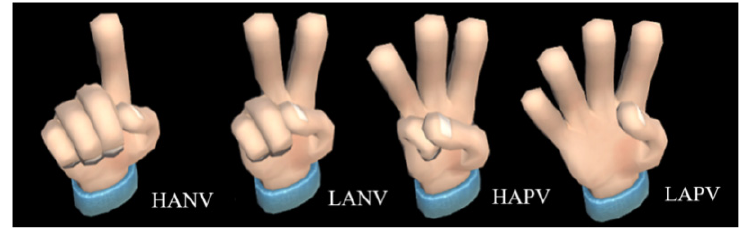
Figure 12. Four hand animation